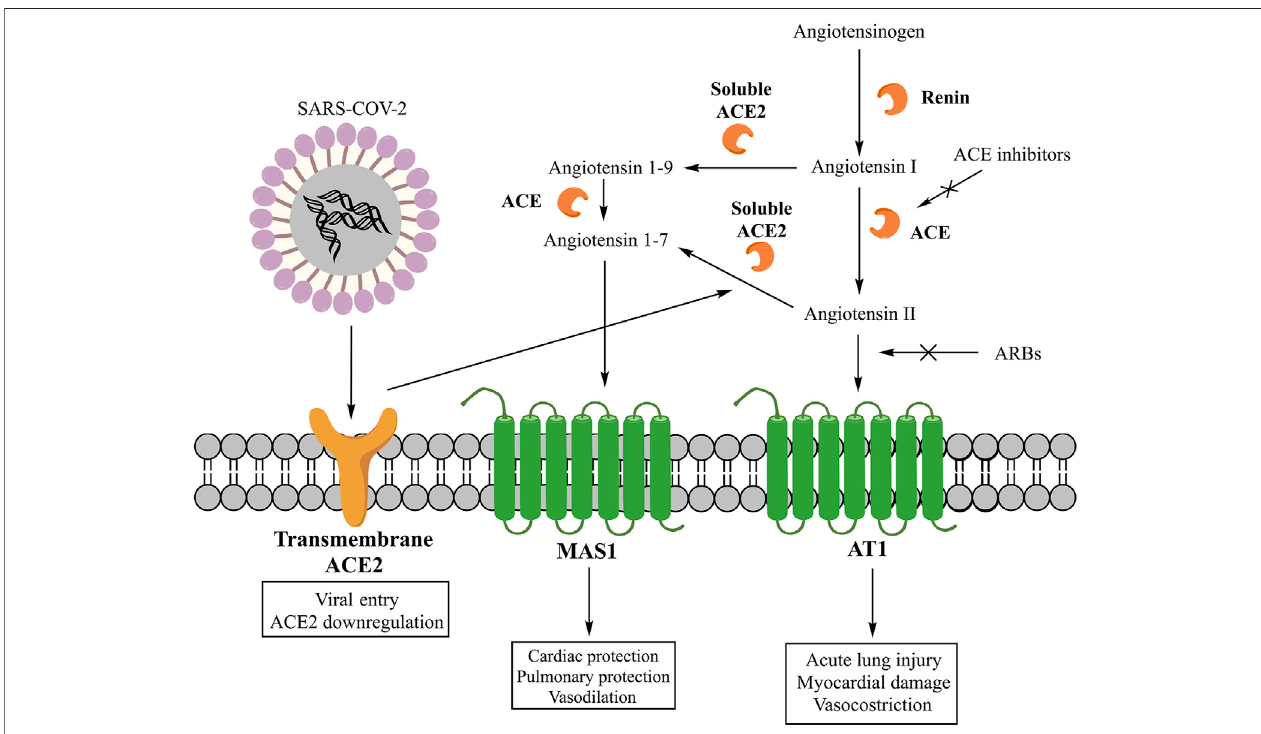
FIGURE 1 | Classic and non-classic RAAS and its interaction with SARS-COV-2. From Mascolo A, Scavone C, Rafaniello C, Ferrajolo C, Racagni G, Berrino L, Paolisso G, Rossi F, Capuano A. Renin-Angiotensin System and Coronavirus disease 2019: A Narrative Review. Front Cardiovasc Med. 2020 Aug 11;7:143. doi: 10.